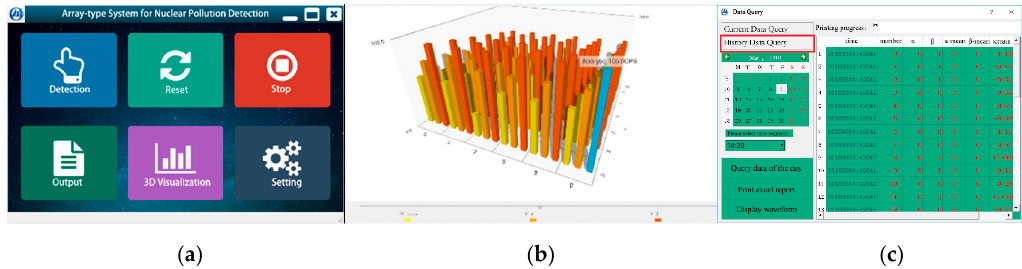
Figure 16. The system’s human-computer interface. ( a ) The main interface. ( b ) The data visualization window. ( c ) The data query window.